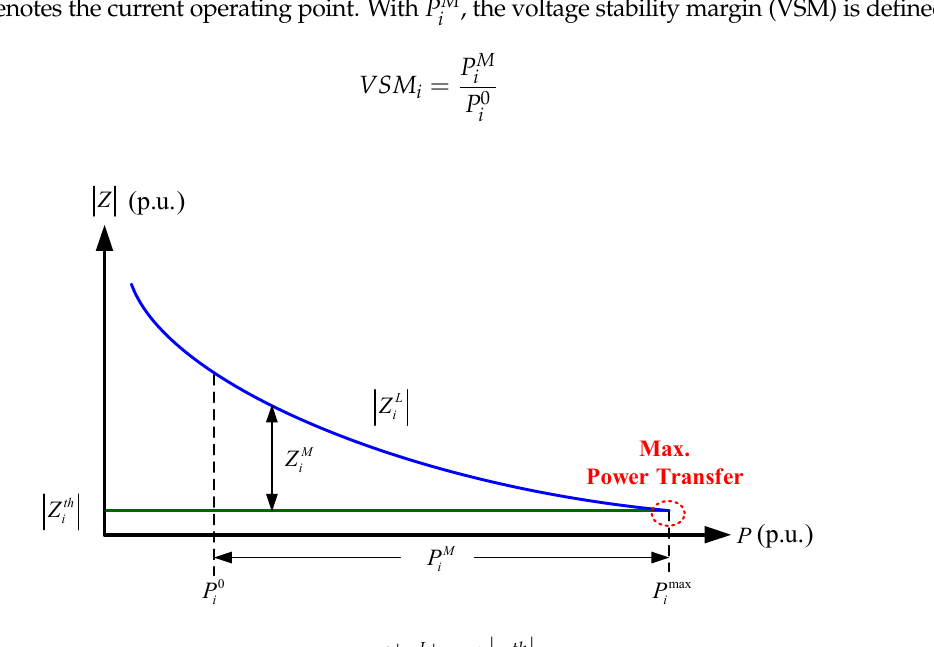
(cid:12) (cid:12) (cid:12) (cid:12) th (cid:12) Z (cid:12) as P i i